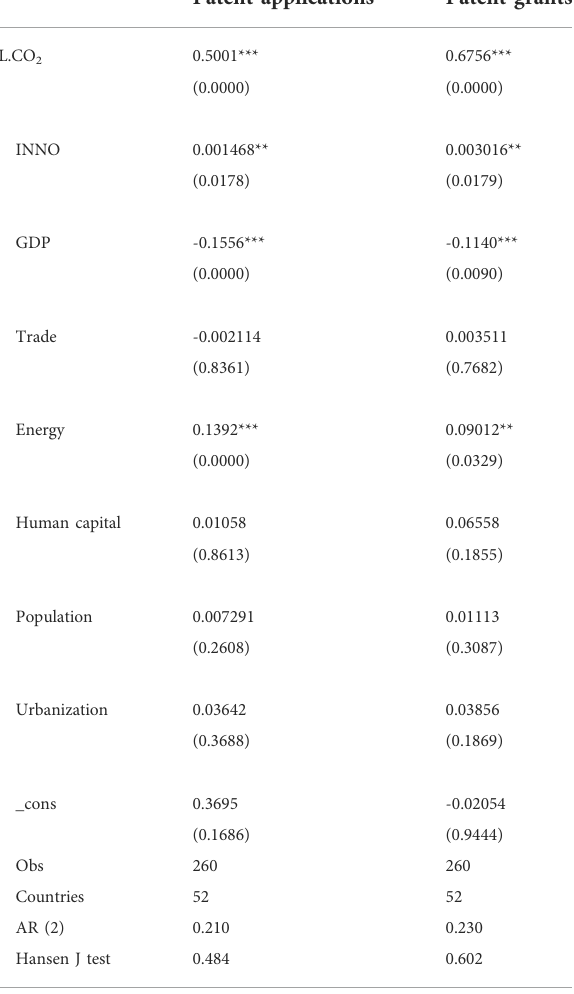
TABLE 3 Innovation and environment quality: 1990 –